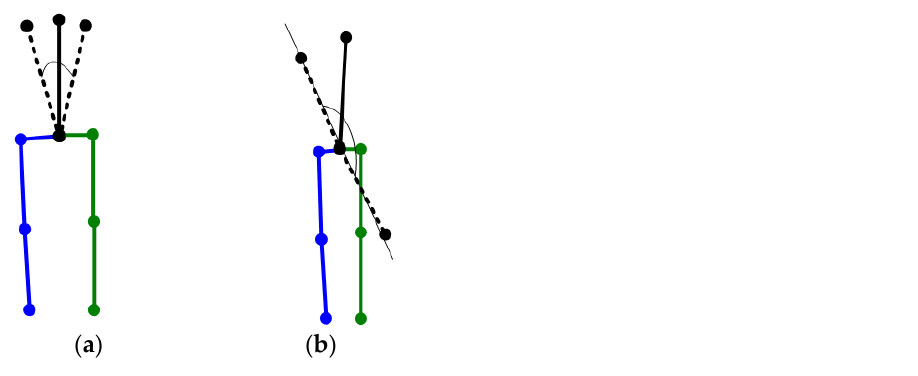
Figure 5. The reasonable range of the spine. ( a ) Left and right range. ( b ) Front and back range. On every subgraph, the reasonable range is between two black dashed lines.